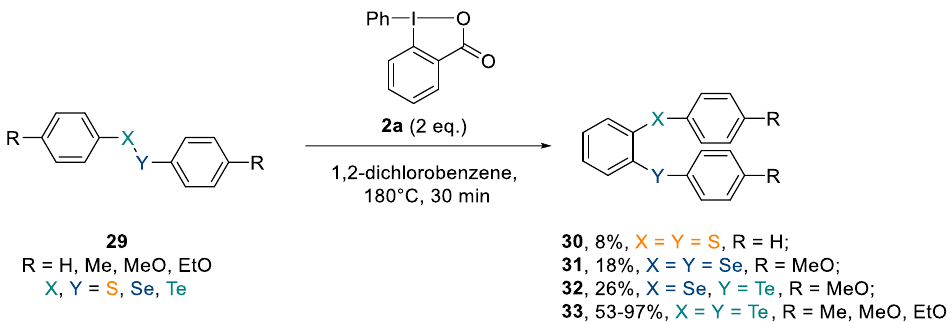
Scheme 6. Reactions of 2a with diarylchalcogenides 29 under reflux